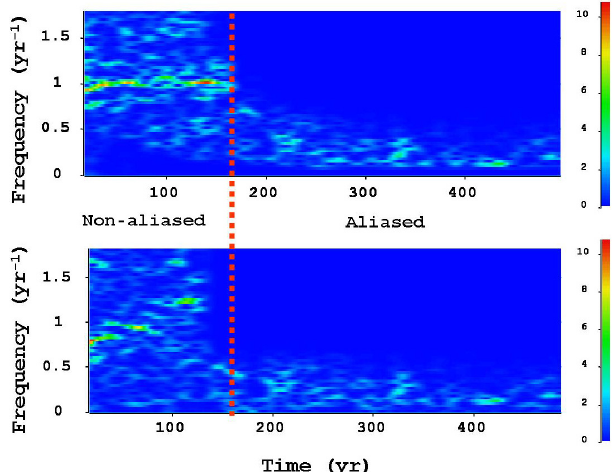
as a function of the time delay Figure 10. Spectrograms of S NO 3 estimate b t . The time delay estimate b t is given by the chronology deduced from the spectrogram (top) and the scalogram (bottom). The red dotted vertical line indicates the time corresponding to the